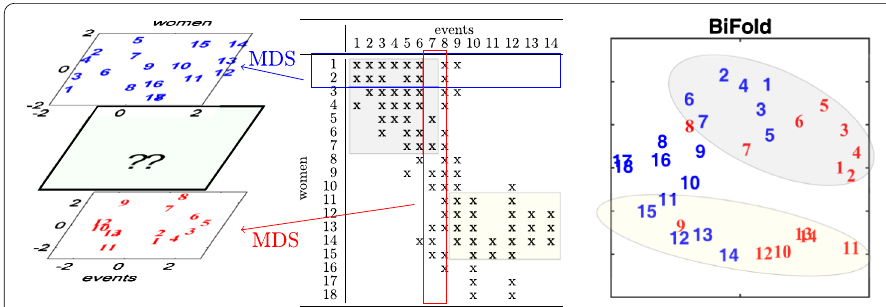
Figure 1 BiFold as a joint visualization. (Middle panel) The classic SouthernWomenDataset [26], where Davis has arranged the table to highlight the social group structures. (Left panel) Independent MDS representations can be created for the women (using inter-row distance) or for the events (using inter-column distance), but those plots cannot be directly merged because the coordinate axes are not same. (Right panel) The BiFold representation gives coordinate representation against a common basis. Note that the significant “clusters” observable in the sorted data matrix (colored rectangles) are matched to spatially clustered sets (colored ellipses) in the BiFold